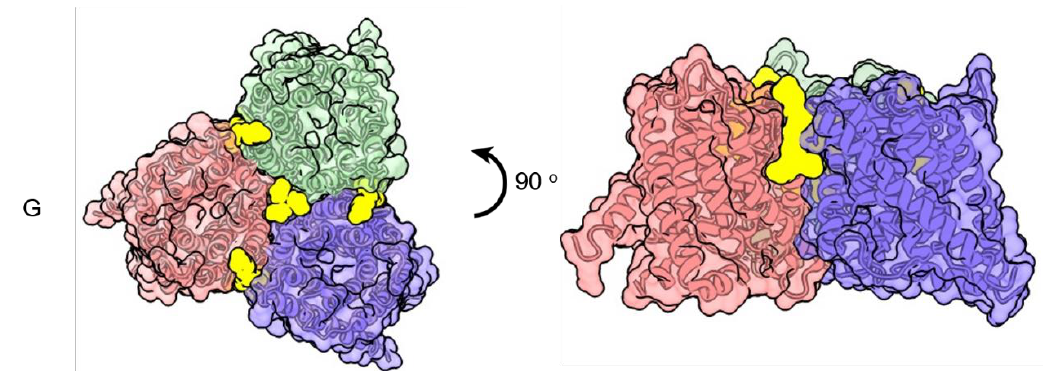
Figure 7. Top and side views of high-resolution cryo-EM structures of ( A ) trimeric AcrB with lipid molecules in yellow (PDB 6BAJ, EMD 7074), ( B ) side views of ACIII photosystem complex (EMD 7286 and 7448), ( C ) dimeric KimA (PDB 6S3K), ( D ) heptameric Ynal (PDB 6RLD, EMD 4990), ( E ) pentameric GlyR (PDB 6PLZ), ( F ) symmetric trimer of Plant Bd SLAC1 (PDB 7EN0; EMD-31197). ( G ) The in meso crystal structure of trimeric rhodopsin bound to monoolein after solubilization with SMA. The structure contains three subunits of the trimer (green, blue, red) and nine monoolein lipids (yellow) within the interfaces (PDB 5ITC).